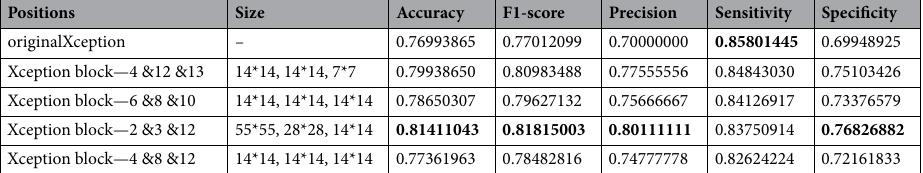
Table 1. Effects of residual attention modules in different locations on the model. Significant values are in bold.